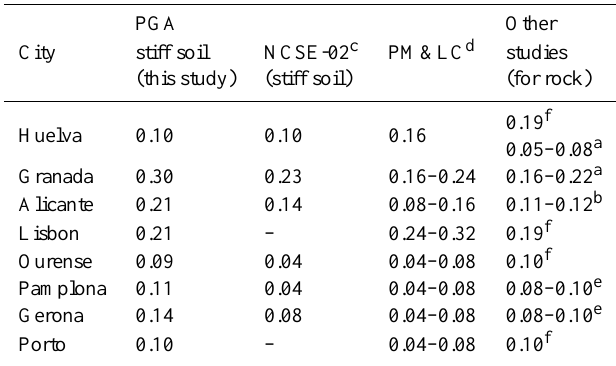
Table 3. Results of PGA ( g ) for selected locations. Results of the present study are compared with values given by the official Spanish seismic code as well as other published